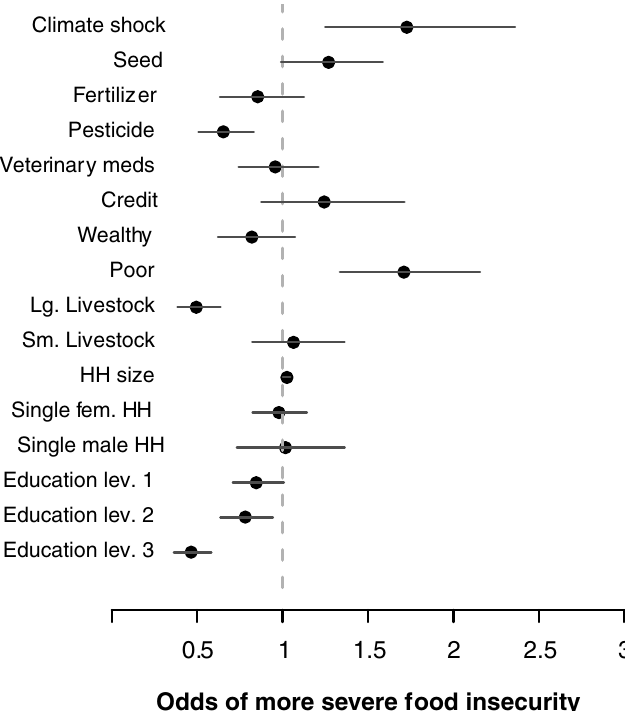
Fig 2. Main effects estimates from the multilevel model. Coefficient estimates are reported on the odds scale with 95% credibility intervals. The indifference value of 1 on the x-axis (dashed line; odds = 1/1) is equivalent to no effect. The model includes interaction effects and varying intercept effects for site and region (Figure A in S1